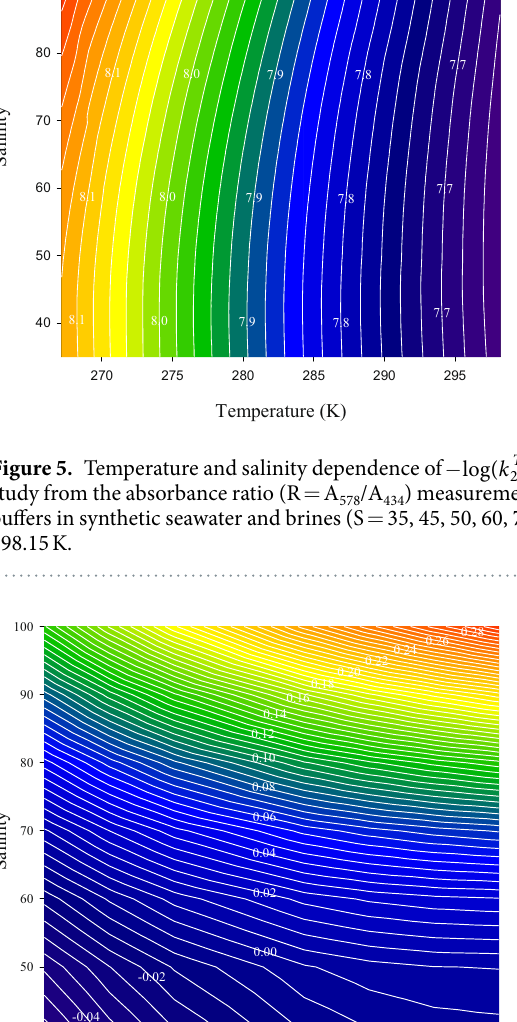
Figure 6. Differences in − k e log( ) T calculated with the Liu et al . (2011) and current parameterizations 2 2 (equation 8). The hatched rectangle represents a portion of the experimental range of Liu et al . 31